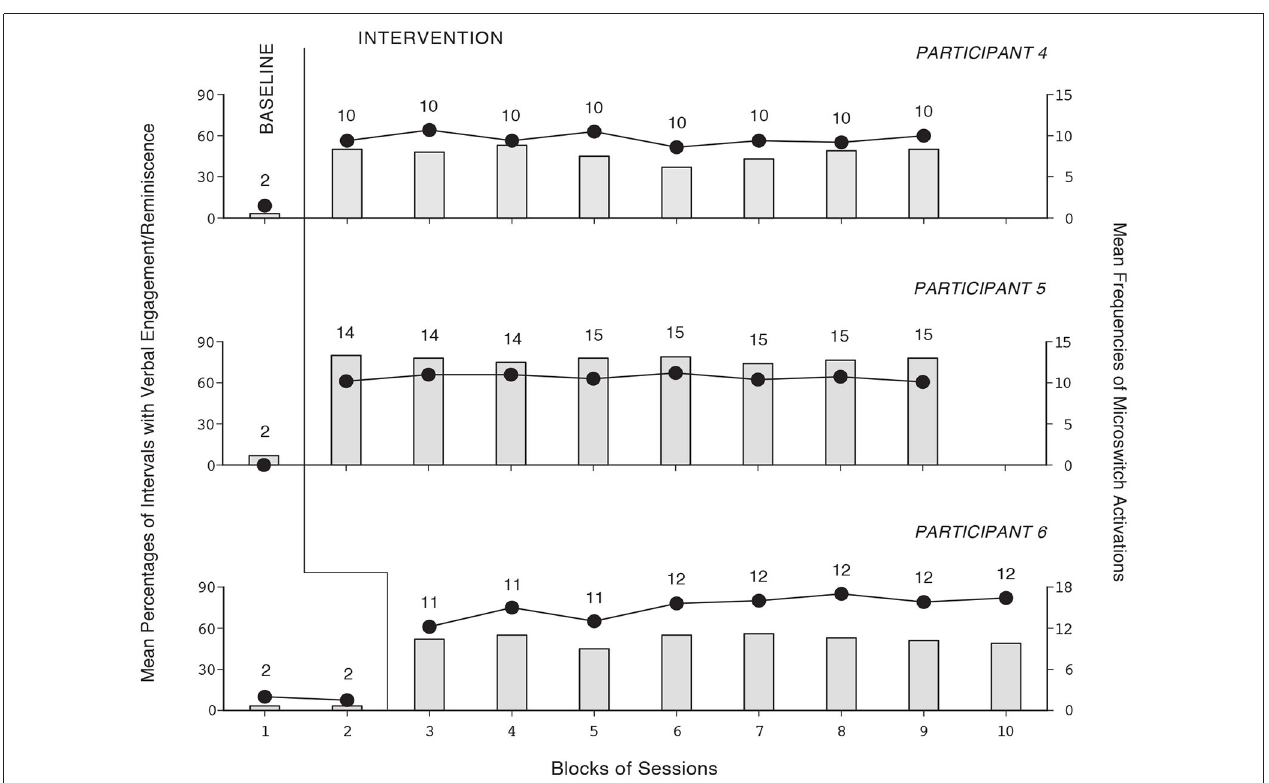
FIGURE 2 | The three panels report the data for Participants 4–6, respectively . Data are plotted as in Figure 1